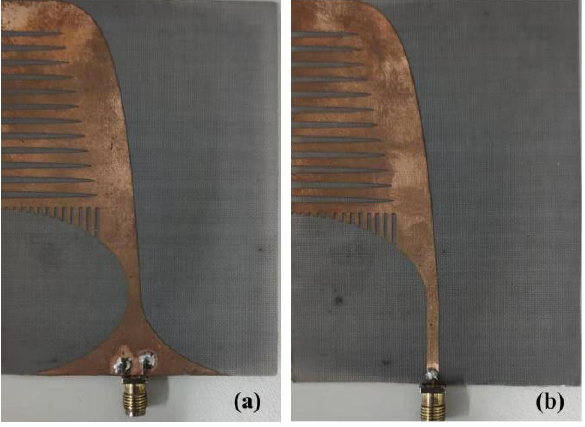
Figure 6. ( a ) The top view and ( b ) the bottom view of the fabricated plasmonic AVA.